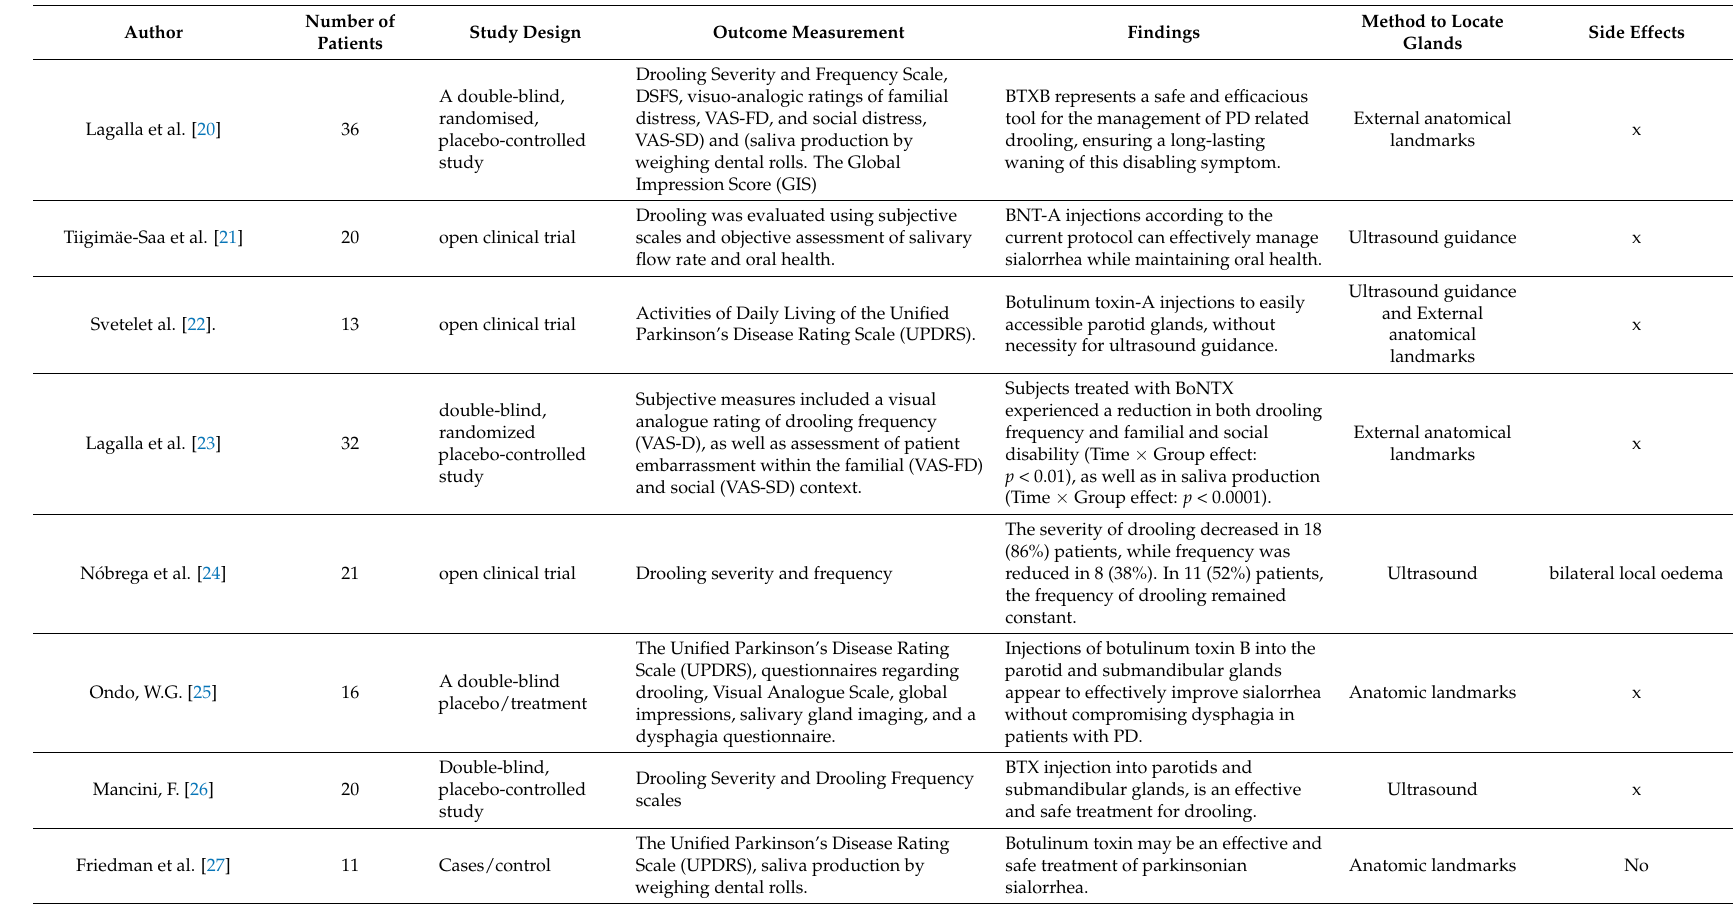
Table 2. Characteristics of Included